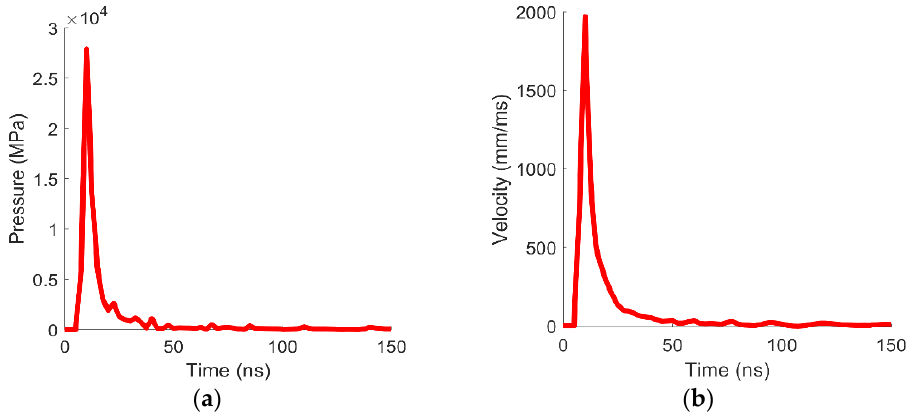
Figure 5. Pressure temporal profile ( a ) and velocity temporal profile ( b ) coming from Helios and applied as boundary condition in LS-Dyna. Notice that the applied pressure is still roughly 250 MPa at 140